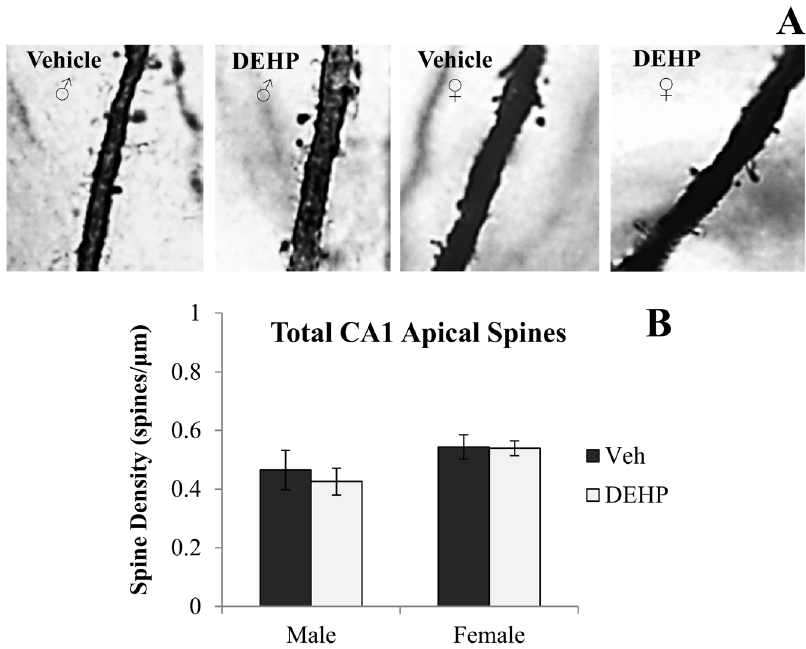
Figure 3. Spine density on apical dendrites of dorsal CA1 hippocampal neurons. (A) Representative photomicrographs of spine density on second order apical dendritic branches of CA1 neurons (100x). Quantification of the total number of basal dendritic spines per m m (B) in male and female rats exposed to di(2-ethylhexyl) phthalate (DEHP) compared to controls (Veh). There were no differences in CA1 apical dendritic spine density in male or female rats exposed to DEHP compared to controls. Error bars represent standard error of the mean.